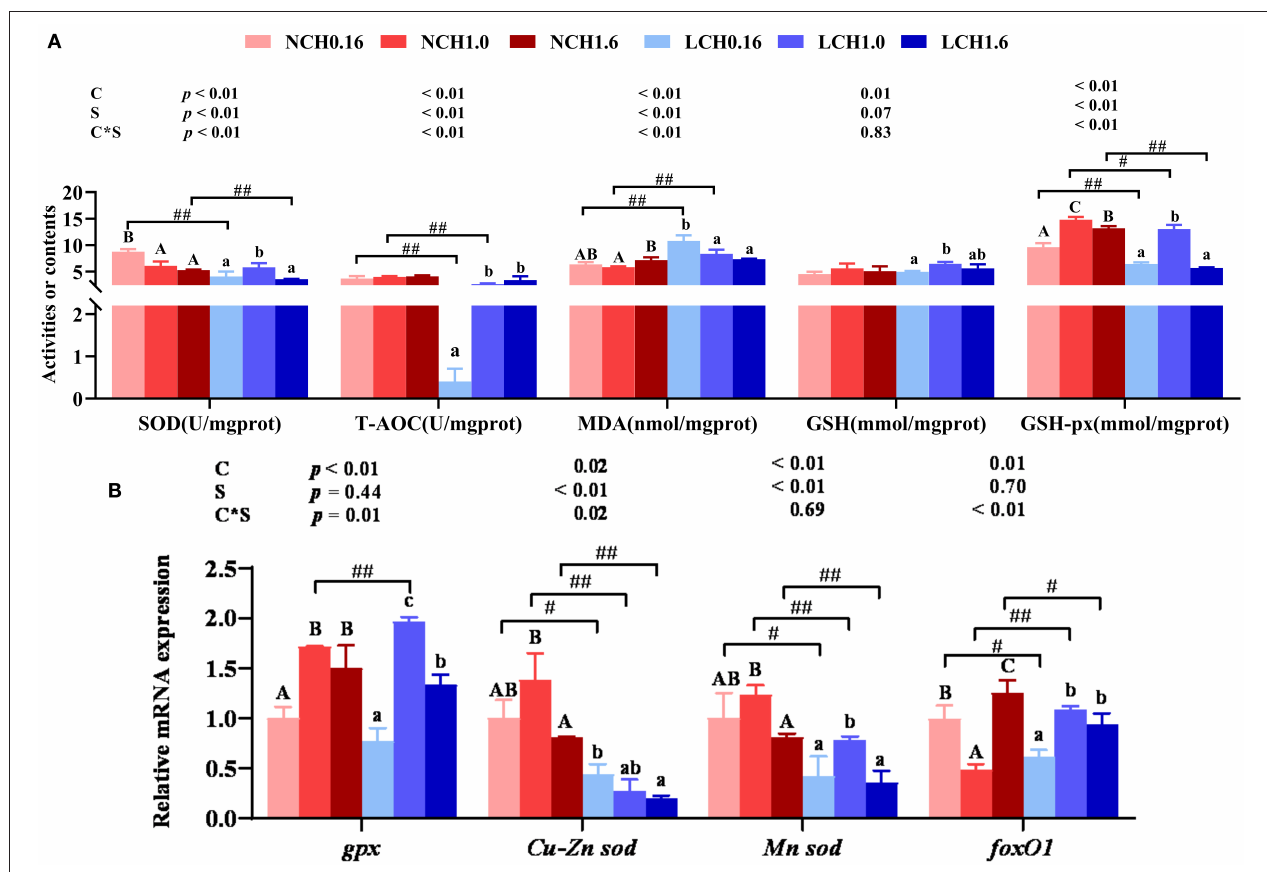
FIGURE 4 | Effects of dietary cholesterol level and water salinity on oxidative stress and antioxidant capacityin liver of juvenile Acanthopagrusschlegelii . oxidation and antioxidant parameters in liver (A) and relative gene expression levels involved in antioxidant capacity in liver (B) . The group of NCH0.16 was set as the reference group, and the mRNA expression levels of target genes were normalized relative to the expression of β -actin . Values are presented as the means ( n = 3), with standard errors represented by vertical bars. Two-way ANOVA P -values are shown in each panel, with “C” representing effects of dietary cholesterol levels, “S” representing effects of salinity, and “C*S” representing interaction between dietary cholesterol levels and salinity. “ABC” representing significant ( P < 0.05) difference between dietary cholesterol levels in normal water salinity (23 psu) and “abc” representing significant ( P < 0.05) difference between dietary cholesterol levels in low water salinity (5 psu) by performing one-way ANOVA. “#” representing significant ( P < 0.05) difference between water salinity with same dietary cholesterol level and “##” representing highly significant ( P < 0 .01) difference between water salinity with same dietary cholesterol level by performing t -test. GSH, glutathione; GSH-px, glutathione peroxidase; SOD, superoxidedismutase; T-AOC, total antioxidation capability; MDA, malonaldehyde; gpx , glutathione peroxidase; Cu-zn sod , Cu-Zn superoxide dismutase; Mn-sod, Mn superoxidedismutase ; foxO1 , forkhead